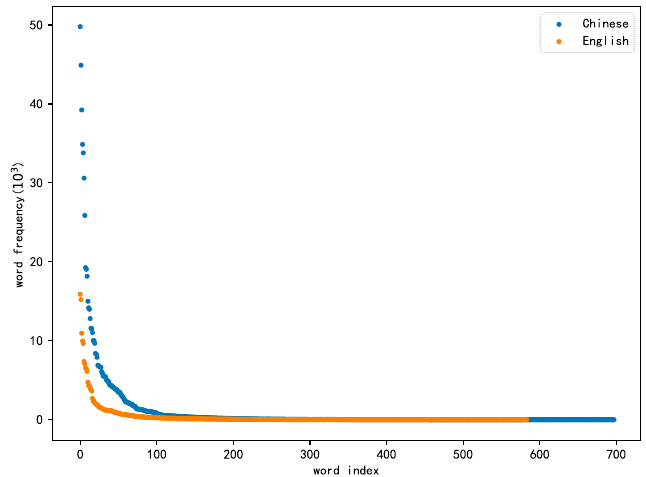
Figure 4. The word frequency of ATC speech for both Chinese and English speech.